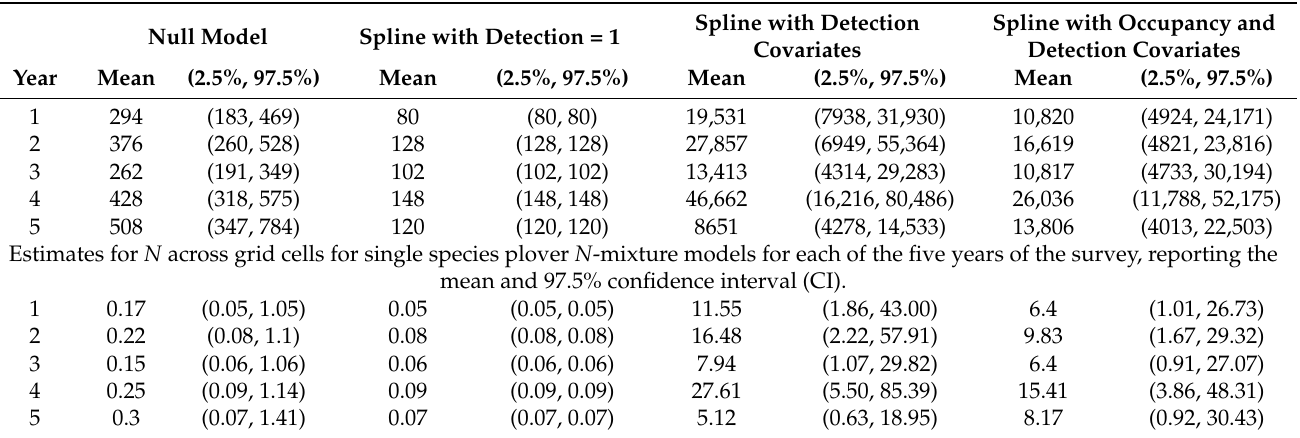
Table 4. Model estimates for piping plover total N for Whiskey Island, reporting the mean and 97.5% confidence interval